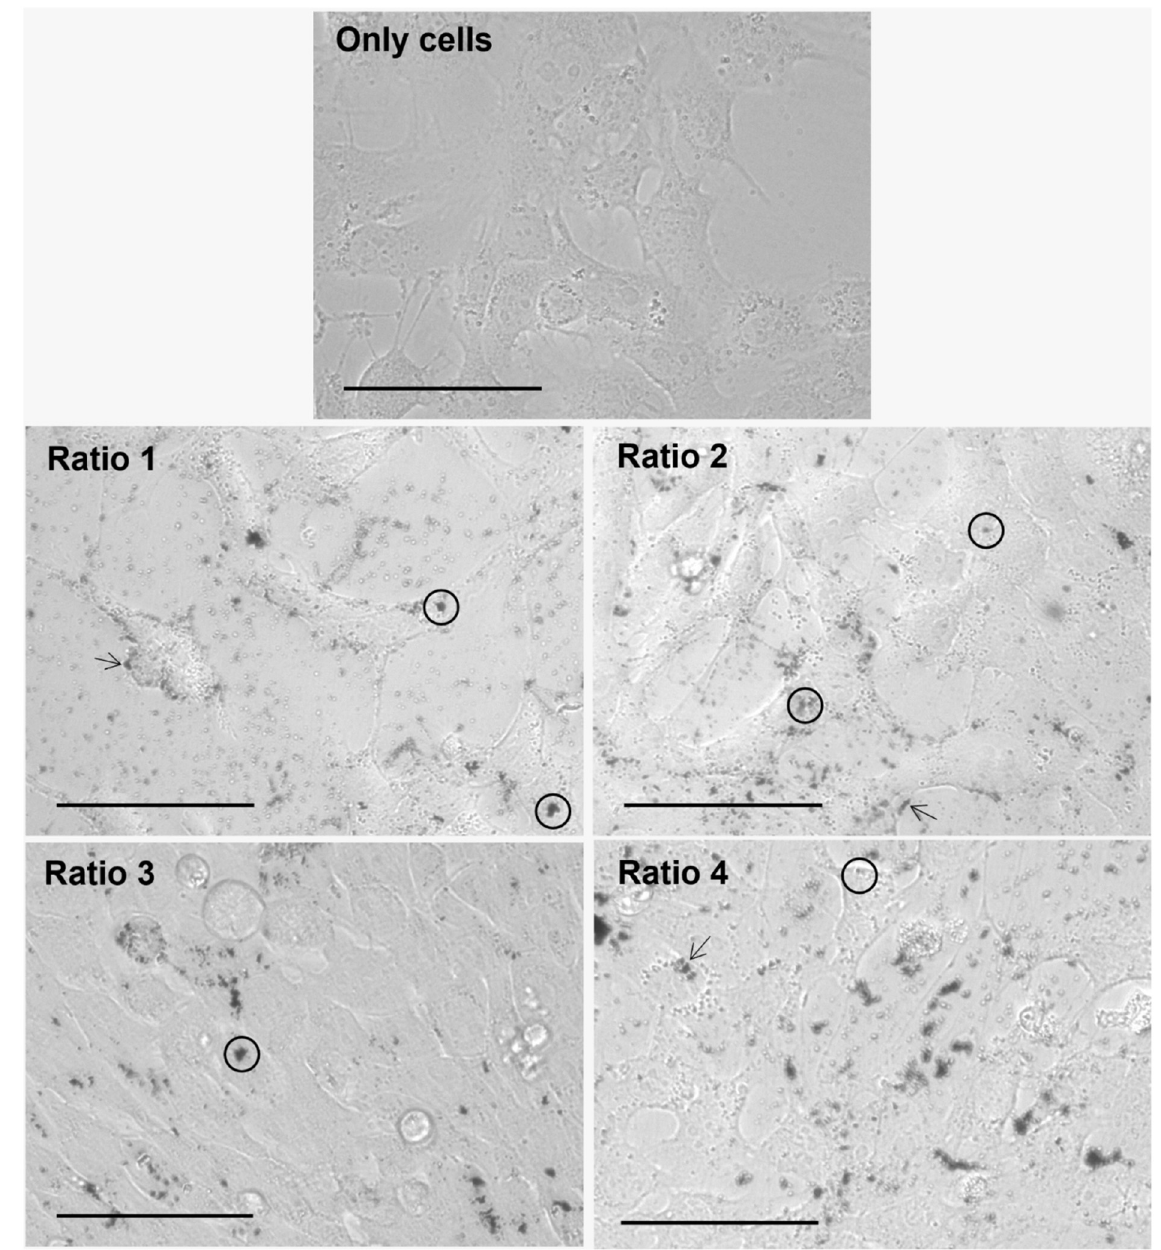
Figure 11. Representative images of 4T1 cells alone (only cells) and after 4 h of incubation with different types of AuNPs (Ratio 1, Ratio 2, Ratio 3 and Ratio 4 AuNPs) at 40 × magnification. AuNPs appear as darker structures either inside the cell (circle) or at the cell surface (arrow). Scale bar = 75 µm.